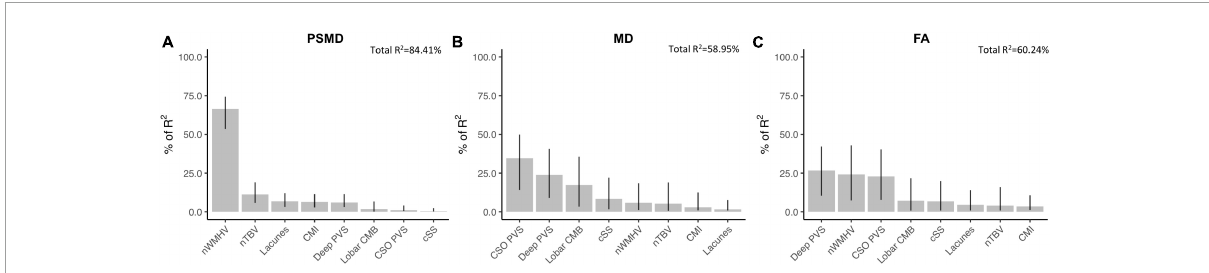
FIGURE2 Associations between DTI metrics and conventional neuroimaging markers of cSVD in probable-CAA subjects. Bar graphs represent the relative contribution of each neuroimaging marker to explaining the variance in PSMD (A) , average skeletonized MD (B) , and average skeletonized FA (C) values among probable-CAA subjects. All neuroimaging markers were entered as independent variables in multiple linear regression models, with each DTI metric as the dependent variable. We applied a model decomposition method available in R package “Relaimpo” to compute the LMG metric. Metrics are normalized to sum to 100%. Lines represent 95% confidence intervals after 1,000 bootstrapping replications.